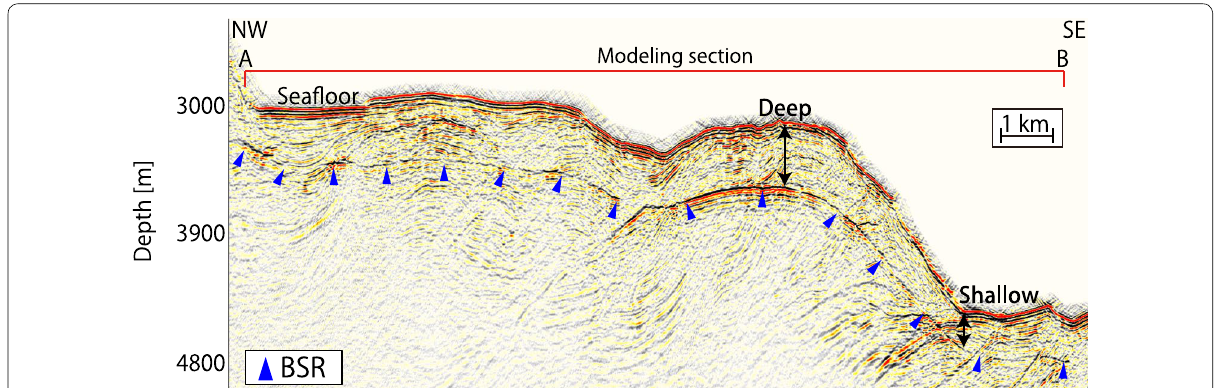
Fig. 7 Example of BSR depth variation in convex-upward and convex-downward seafloor regions southwest of Kii Peninsula. BSRs are marked with blue triangles. Their depths are deeper in the convex-upward seafloor region and shallower in the convex-downward seafloor region relative to the neighboring areas. The two-way travel time is converted to subseafloor depth using a P-wave velocity obtained from Site C0002 of the IODP Expedi- tions (Expedition 314 Scientists